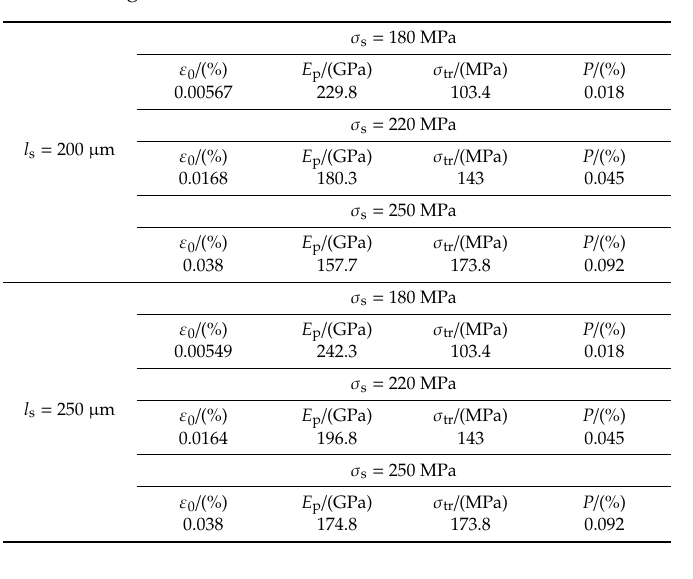
Table 4. The e ff ect of the saturation matrix crack spacing ( l s = 200 and 250 µ m) on tensile stress–strain curve, tangent modulus, interface debonding fraction and broken fiber fraction of SiC / SiC composite subjected to stochastic loading of σ s = 180, 220 and 250